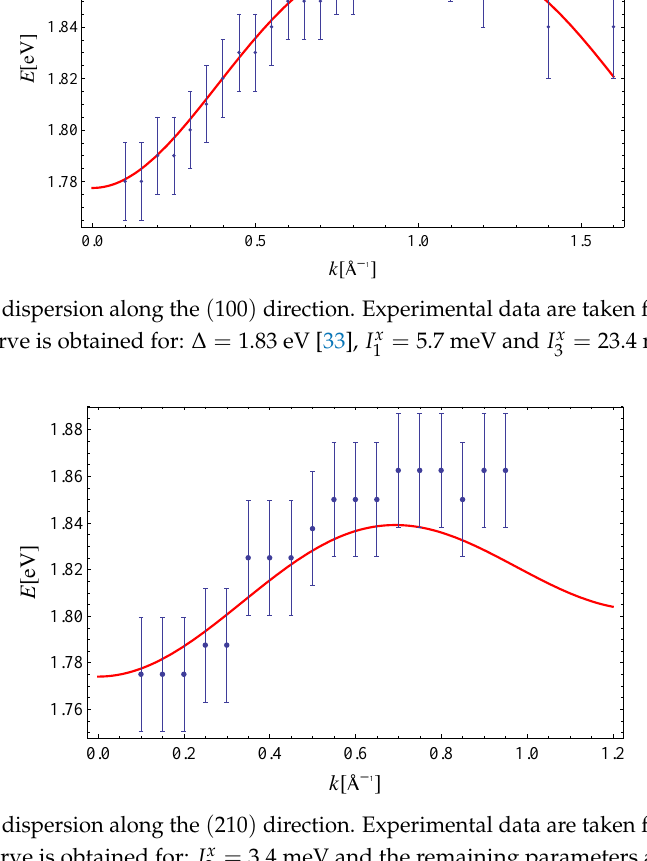
Figure 3. Exciton dispersion along the ( 210 ) direction. Experimental data are taken from Reference [3]. = 3.4 meV and the remaining parameters are the same as in The theoretical curve is obtained for: I x 2 Figure